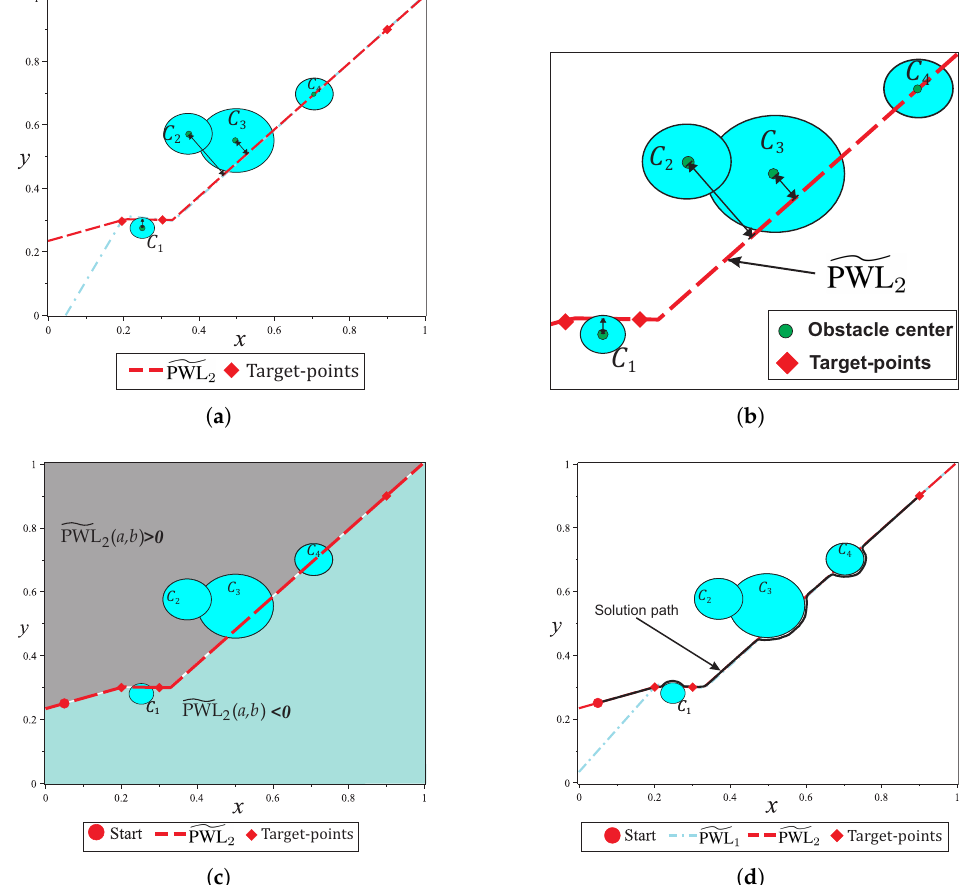
Figure 14. Criterion to select the repulsion parameter. ( a ) Environment map. ( b ) Position of obstacles with respect to (cid:103) PWL 2 ( x , y , λ ) . ( c ) Positive and negative regions with respect to (cid:103) PWL 2 ( x , y , λ ) . ( d ) Solution path using systematic criterion to select repulsion